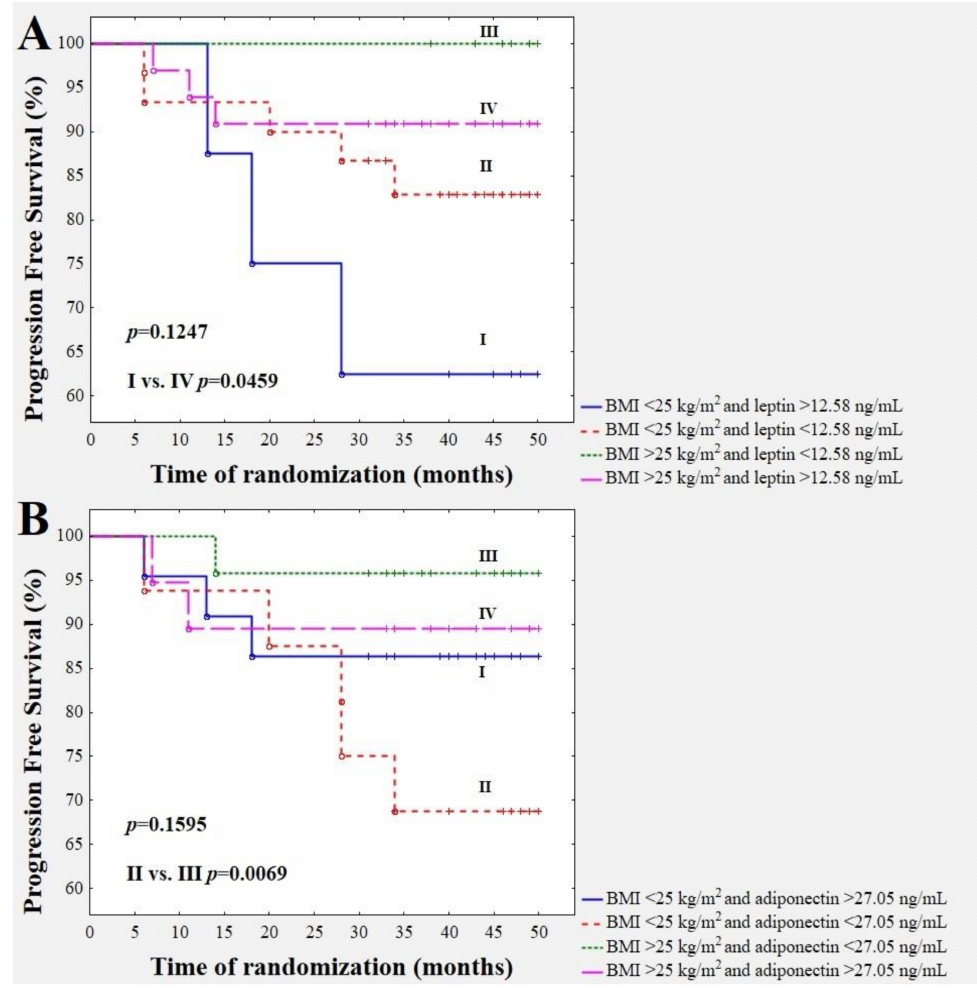
Figure 4. Combination of BMI with the leptin concentration ( A ) and the combination of BMI with the adiponectin concentration ( B ) with respect to disease relapse prediction.